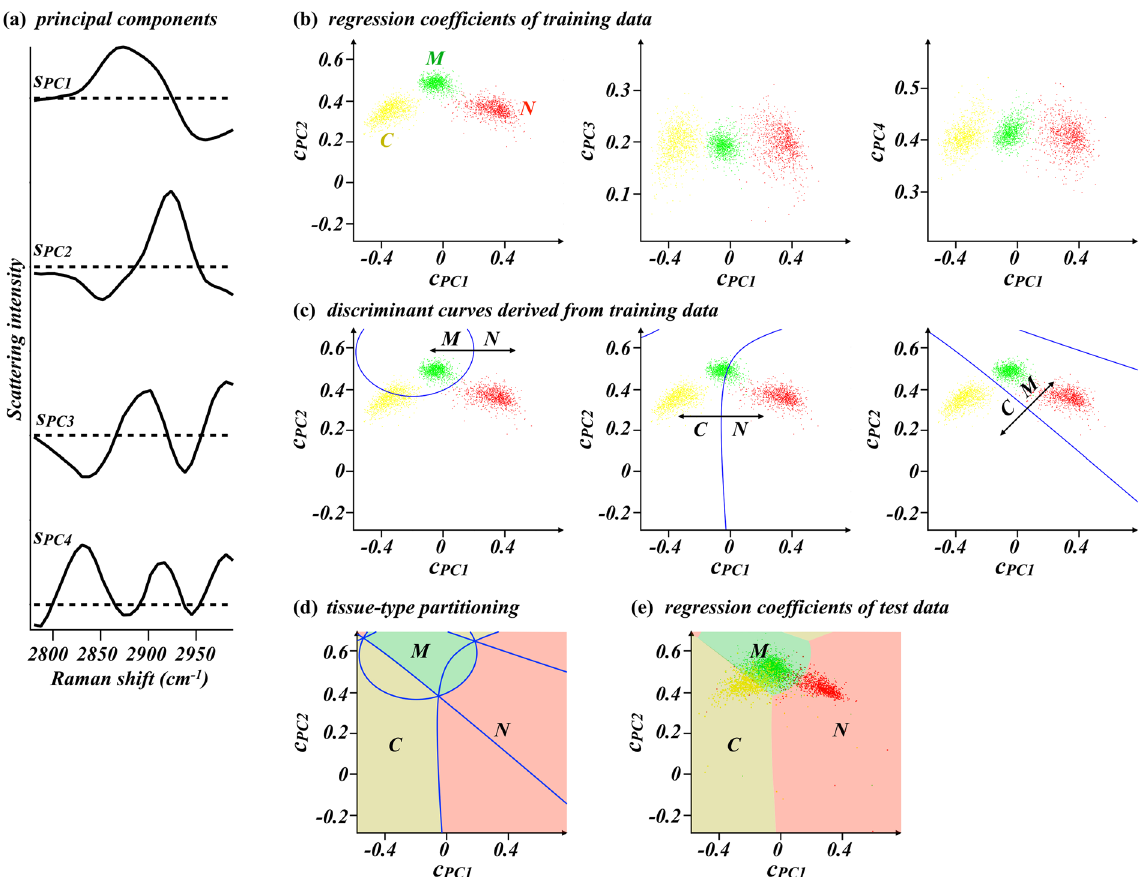
Figure 2. ( a ) The first to fourth principal components of training dataset composed of 1000 peripheral nerve spectra, 1000 connective tissue spectra, and 1000 skeletal muscle tissue spectra ( s PC1 to s PC4 ). Horizontal dashed lines indicate zero intensity for individual principal components. ( b ) Principal component regression coefficient plots of the training spectra. c PC1 , c PC2 , c PC3 , and c PC4 are regression coefficients to the four principal components shown in ( a ) ( s PC1 , s PC2 , s PC3 , and s PC4 , respectively). ( c ) Discriminant curves discriminating the Raman spectra groups of peripheral nerve from skeletal muscle tissues (left), peripheral nerve from connective tissues (middle), and connective tissues from skeletal muscle tissues (right) in the space of c PC1 to c PC2 plot. ( d ) A graph overlaying all the discriminant curves in ( c ) and three distinct areas assigned to nerve-positive prediction region (light red), connective-tissue-positive prediction region (dark yellow) and muscle-positive prediction region (light green). Individual areas were derived from the M/N and C/N discrimination curves, the C/N and C/M discrimination curves, and the M/N and C/M discrimination curves in ( c ), respectively. ( e ) Results of principal component regression of the 3840 test spectra with the four principal components shown in ( a ). The tissue-type partitions are overlaid. N: peripheral nerve bundle. C: connective tissue. M: skeletal muscle